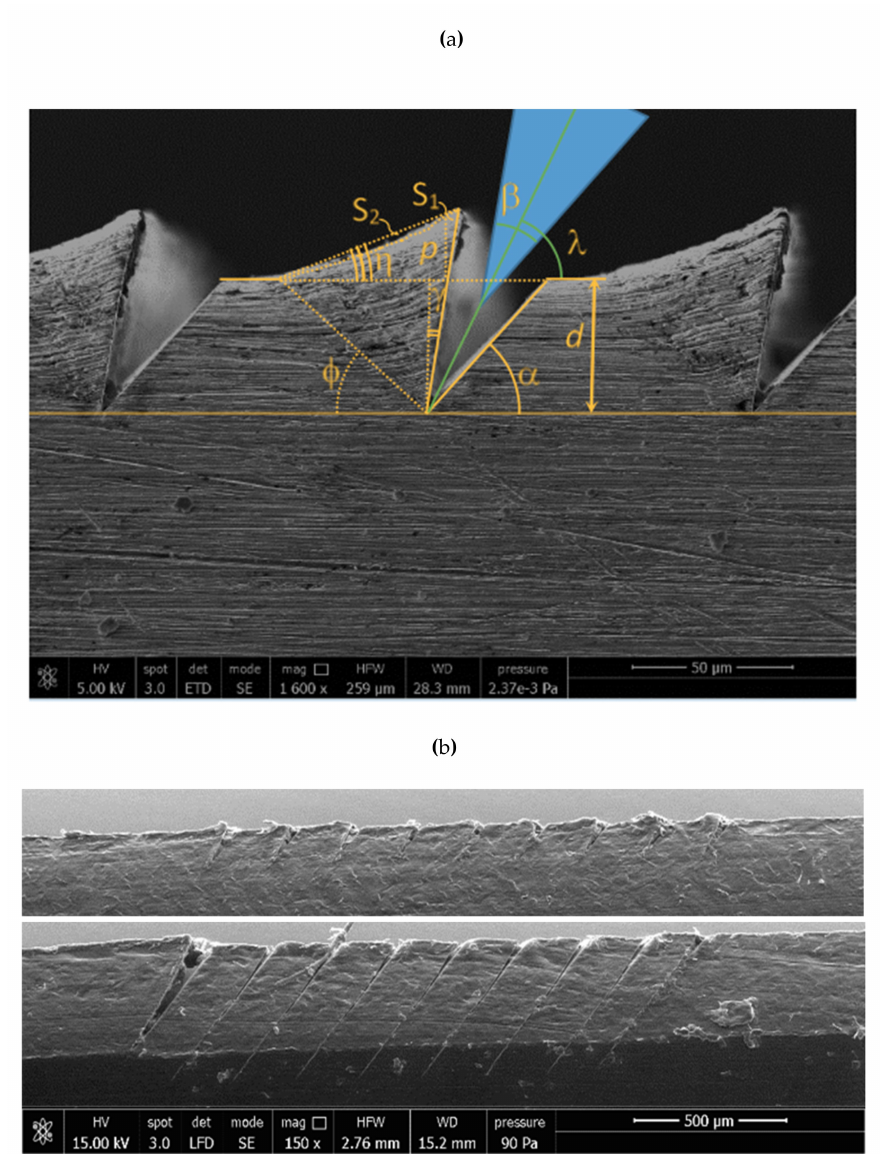
Figure 4. ( a ) SEM micrograph of durable mold made by Al 6060-T6: wedge angle definitions. Plastic deformation is enhanced by the deflection of stripes. ( b ) SEM micrograph of acetal (yield strength 68 MPa) with blade cutting at 100 (top) and 500 (bottom) µ m depth